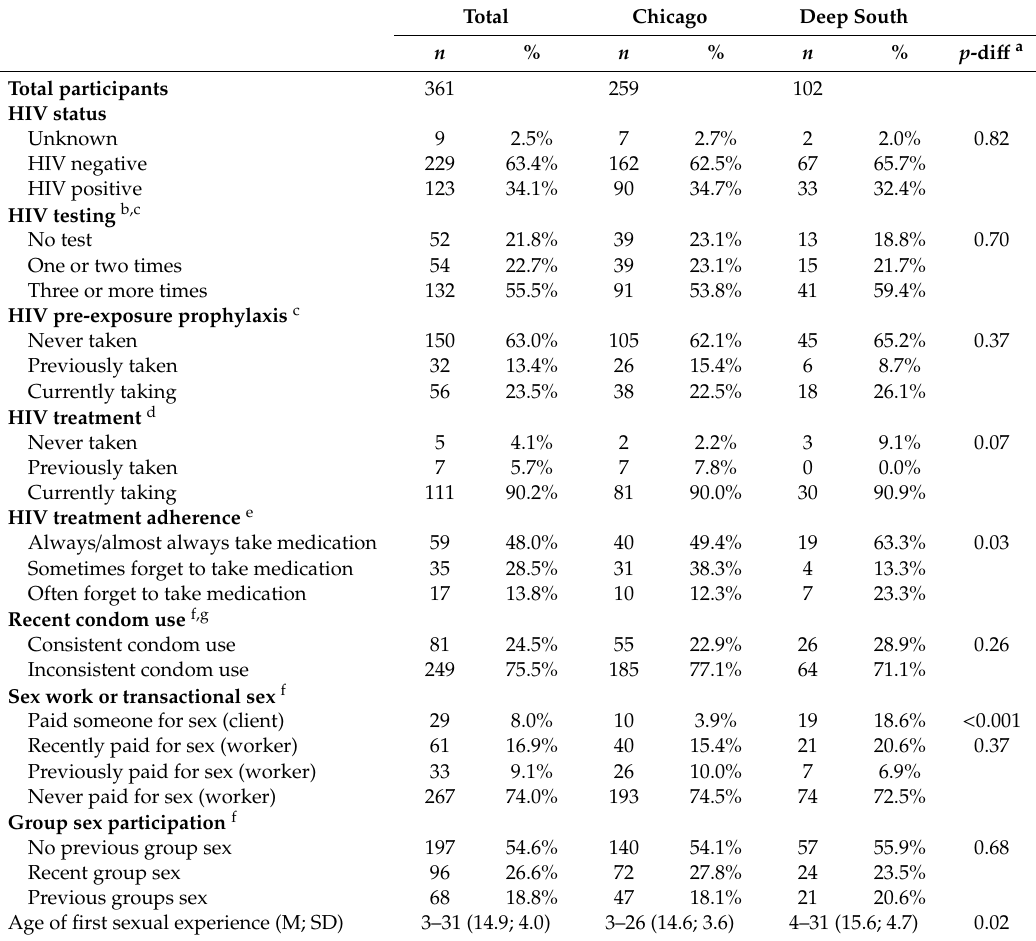
Table 3. HIV and sexual health practices at baseline among cisgender Black gay, bisexual, and other men who have sex with men participating in the Neighborhoods and Networks (N2) Cohort Study , enrolled as of 31 December